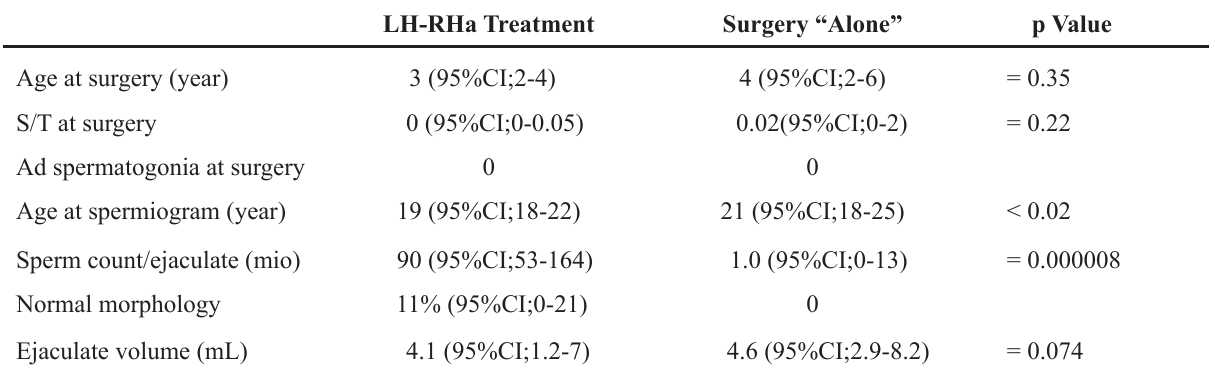
Table 5 – Summary of